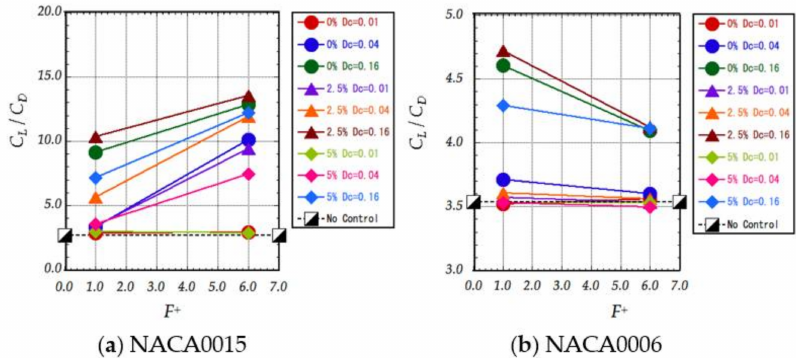
Figure 9. Aerodynamic performance versus Burst frequency: α = 12 ◦ , BR = 10%, Re = 6.3 × 10 4